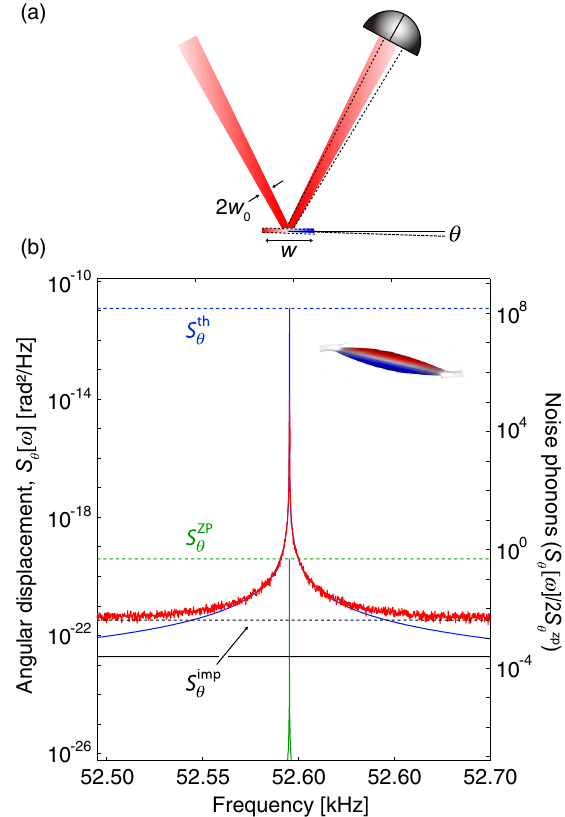
FIG. 3. Optical lever measurement with an imprecision below thatat thestandardquantumlimit. (a)Schematicoftheopticallever technique: AGaussian beam with waist w 0 is reflected off a torsion ribbon of width w (the beam waist is at the ribbon [21]). Ribbon deflection θ ismonitoredusingasplitphotodiode.(b)Displacement of a w ¼ 400 μ m ribbon measured using a w 0 ≈ 200 μ m, P ¼ 4 mW optical lever. Solid curves correspond to data (red), a thermal noise model (blue), and the inferred zero-point spectral density [21] (green). Dotted lines are guides to the eye for the peak thermal (blue), zero-point (green), and imprecision (black) noise. The ideal imprecision [Eq. (2) with η ¼ 1 ] is shown as a solid black